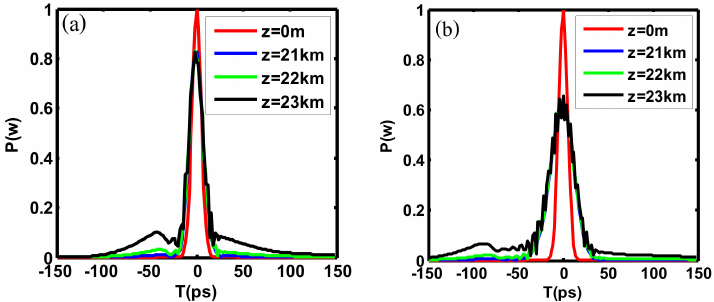
Figure 4. The pulse waveform comparison at different propagation distances. ( a ) The first case in Table 1; and ( b ) the second case in Table 1.